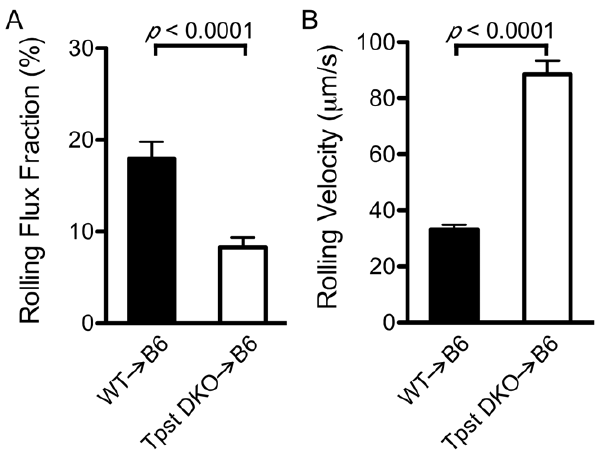
Figure 2. P-selectin dependent rolling in vivo. Surgical exterior- ization of the cremaster muscle was used to induce P-selectin-dependent leukocyte rolling in post-capillary venules. (A) The rolling flux fraction in 49 venules from 7 WT R B6 mice and 39 venules from 7 Tpst DKO R B6 mice was determined. (B) Mean rolling velocities were determined from an average of 8.5 leukocytes/venule in the same venules as the rolling flux fractions. All values are reported as mean 6 S.E.M.